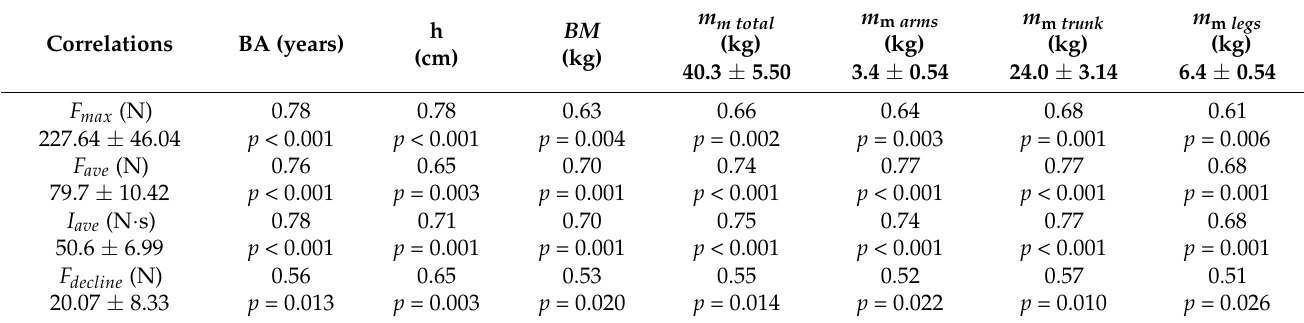
Table 2. Correlations of anthropometric, body composition indices: BA , h , 𝐵𝑀 , 𝑚 (cid:3040) (cid:3047)(cid:3042)(cid:3047)(cid:3028)(cid:3039) , 𝑚 (cid:2923) (cid:3028)(cid:3045)(cid:3040)(cid:3046) , 𝑚 (cid:2923) (cid:3047)(cid:3045)(cid:3048)(cid:3041)(cid:3038) , and 𝑚 (cid:2923) (cid:3039)(cid:3032)(cid:3034)(cid:3046) with tethered swimming indices: 𝐹 (cid:3040)(cid:3028)(cid:3051) , 𝐹 (cid:3028)(cid:3049)(cid:3032) , 𝐼 (cid:3028)(cid:3049)(cid:3032) , and 𝐹 (cid:3031)(cid:3032)(cid:3030)(cid:3039)(cid:3036)(cid:3041)(cid:3032) . Correlations